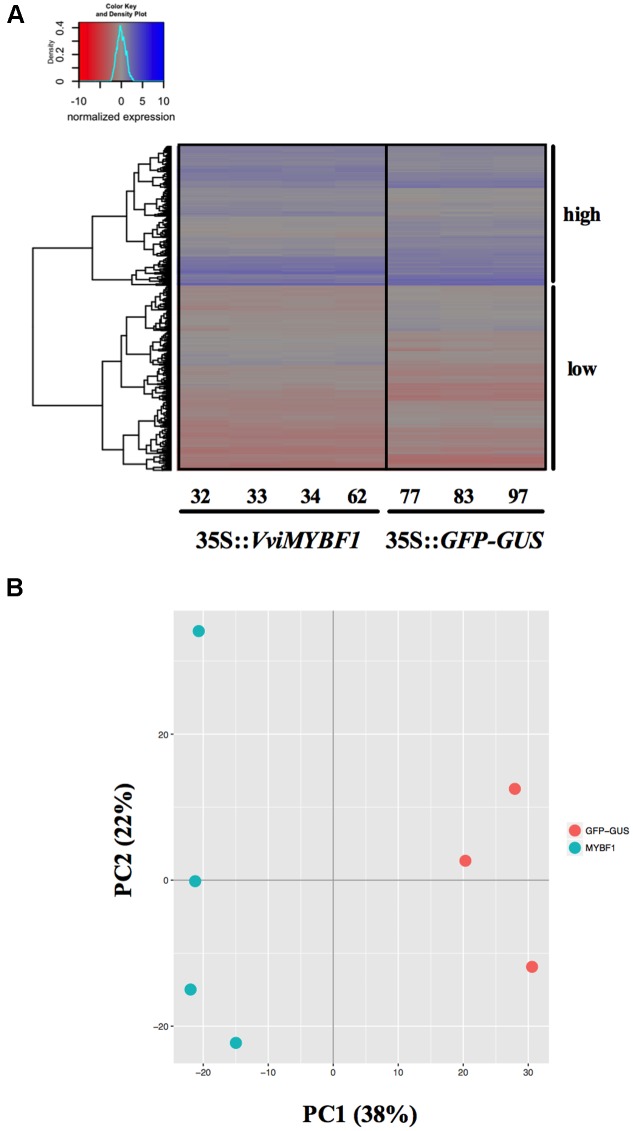
Microarray analysis. (A) Changes in expression of the differentially expressed (DE) probesets presented as a heat map. The dendrogram on the left in (A) illustrates the clustering using euclidean distance of the DE genes into two blocks based on high (blue) and low (red) expression. These two blocks are highlighted on the right. The distribution of the quantile normalized expression values is shown as color key on the topleft. Note that these values were also scaled to have mean zero and standard deviation one. Sample names are indicated on the x-axis with MYBF1 samples on the left and control samples on the right. (B) Principal component analysis (PCA) of gene expression in hairy roots expressing MYBF1 (blue) or GFP control (red). The plot shows the first two principal components (PC1 and PC2) that account for 38% and 22% of the total variation of the data.